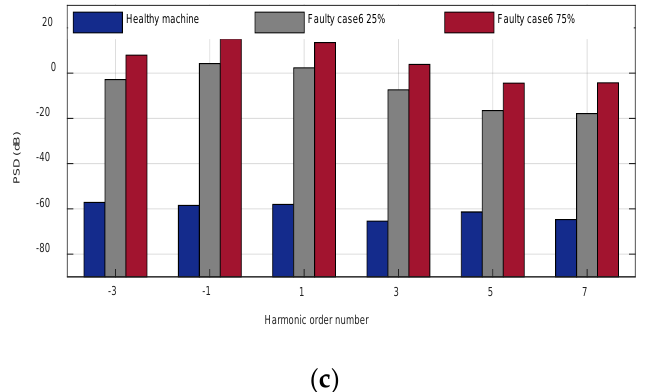
Figure 28. Faulty case 6: ( a ) PMSM current spectra normalized plot under 25%; ( b ) PMSM current spectra normalized plot under 75%; ( c ) ASBCs harmonics variations.